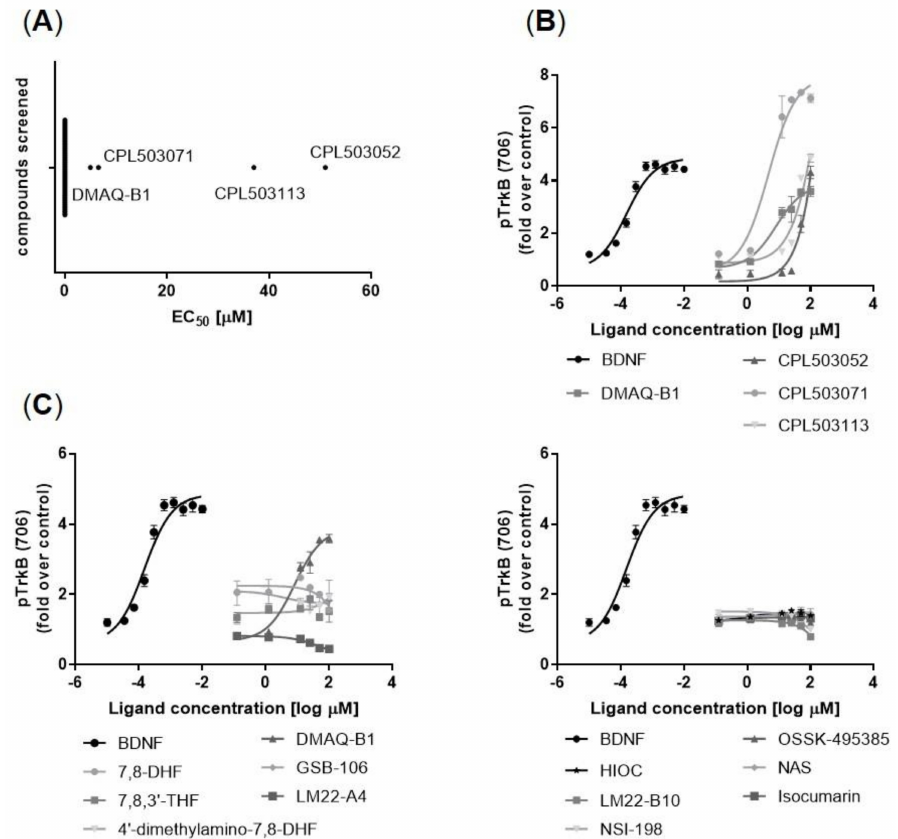
Figure 3. Orthosteric activity of compounds measured as the fold change of TrkB phosphorylation (Y706), determined by enzyme-linked fixed-cell immunoassay (ELFI) method in the SN56 T48 cell line. ( A ) Screening of 59 molecules led to the identification of 4 compounds with orthosteric activity against TrkB. Molecules with no orthosteric activity are marked on the graph as EC 50 = 0 µ M; ( B ) Representative dose–response curves for active TrkB agonist compounds; ( C ) Lack of activity against the TrkB receptor for several compounds described in the literature as TrkB agonists. Data are presented as mean ± SEM, n =